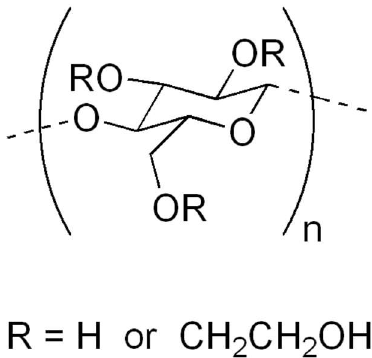
Figure 2. Hydroxyethylcellulose gelificant.